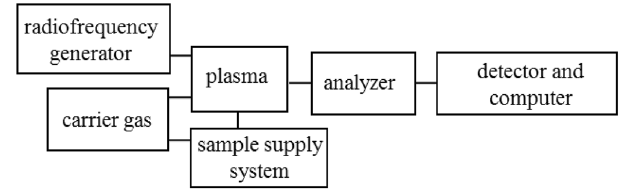
Figure 2. Block diagram of a typical instrument used for